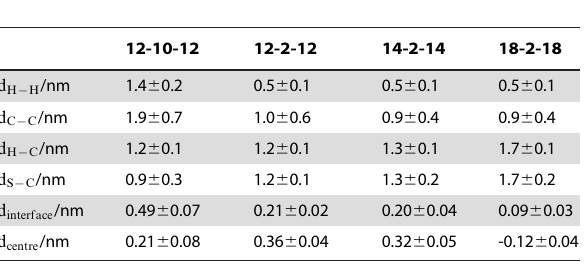
Table 2. Data extracted from the MD